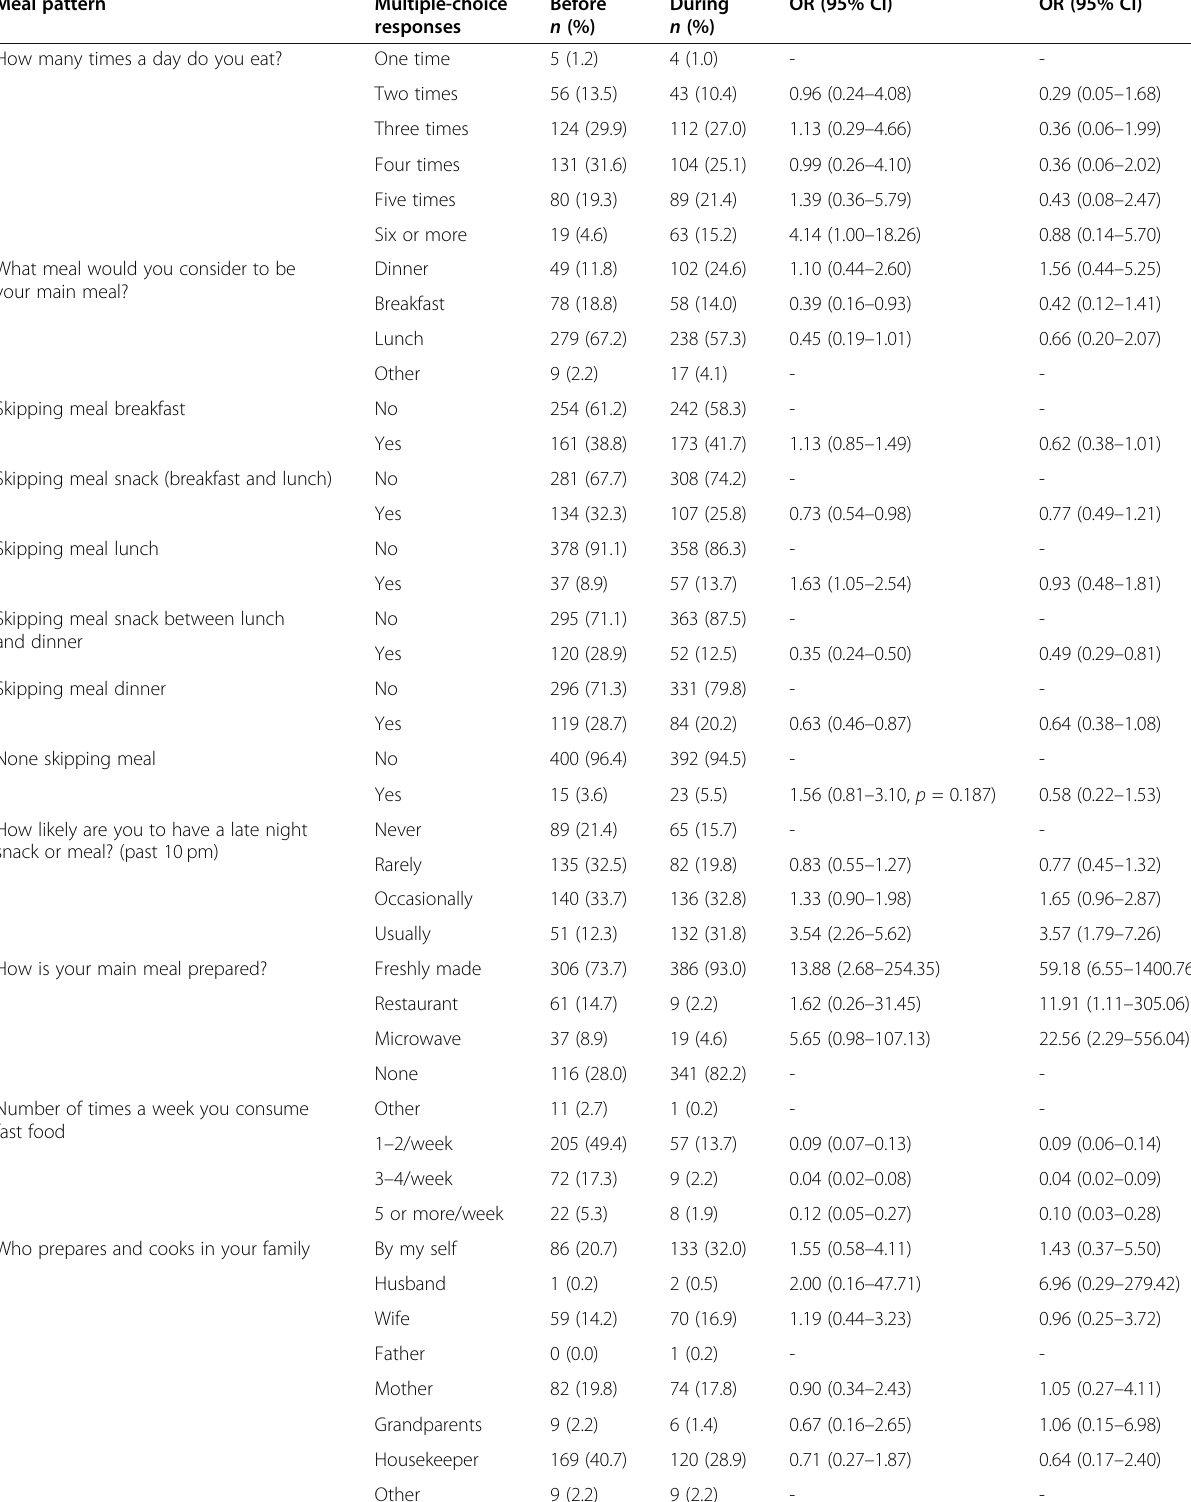
Table 2 Multivariate analysis between two periods using logistic regression for meal pattern Meal pattern Multiple-choice